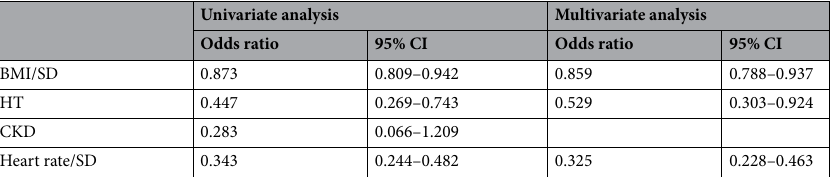
Table 3. Univariate and multivariate analysis of the relationship of clinical variables with normal inflow pattern. BMI, body mass index; CI, confidence interval; CKD, chronic kidney disease; HT, hypertension; SD, standard deviation.